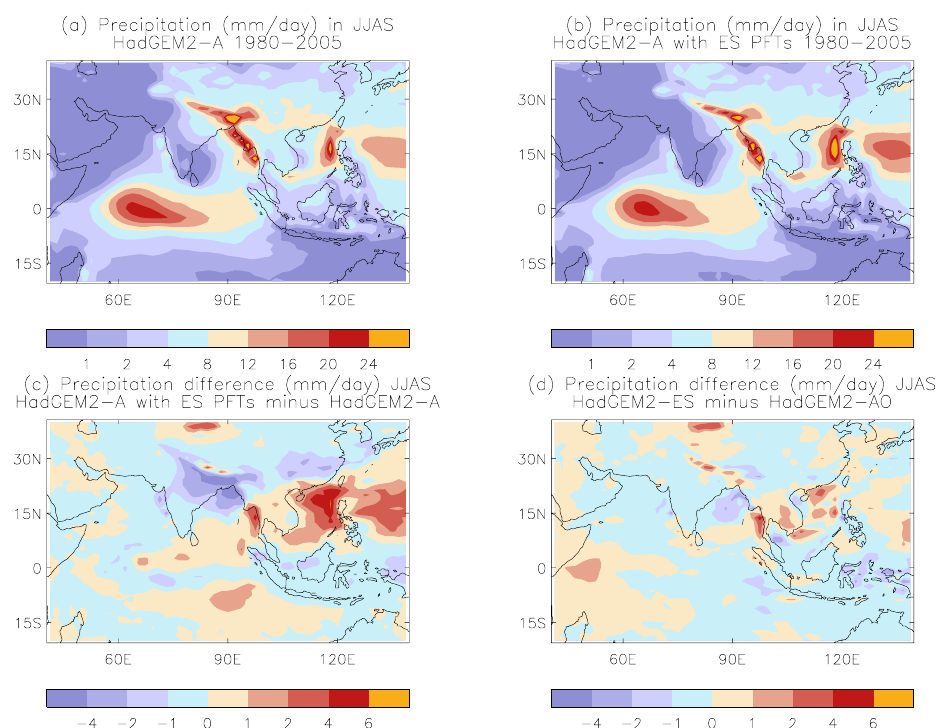
Fig. 5. Precipitation in JJAS (mmday − 1 ) in (a) HadGEM2-A and (b) the HadGEM2-AE experiment, and differences (c) HadGEM2-AE minus HadGEM2-A and (d) HadGEM2-ES minus HadGEM2-AO.